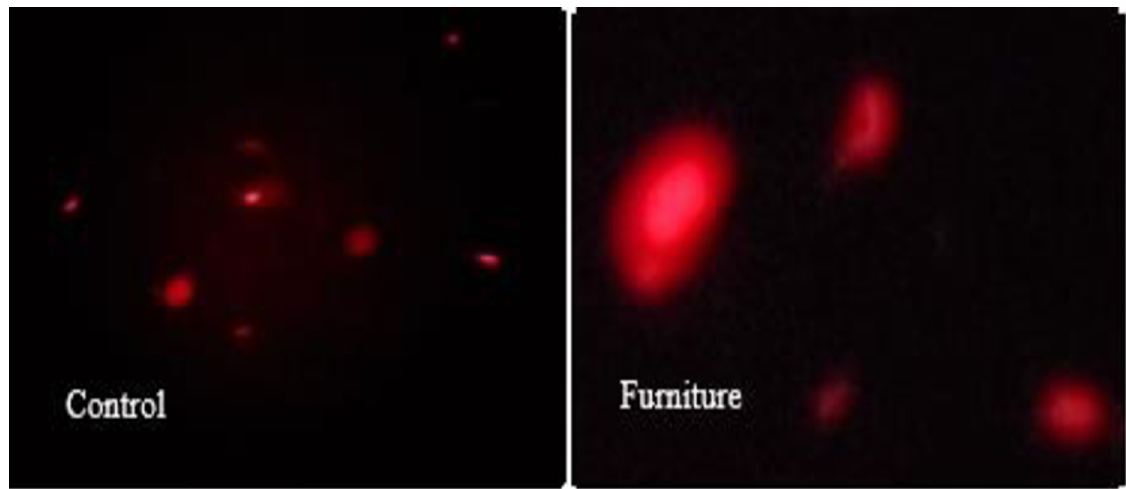
Fig 1. Fluorescence photomicrograph of blood lymphocytes from control and furniture group stained with Acridine Orange after processed through Single Cell Gel Electrophoresis (Comet assay).